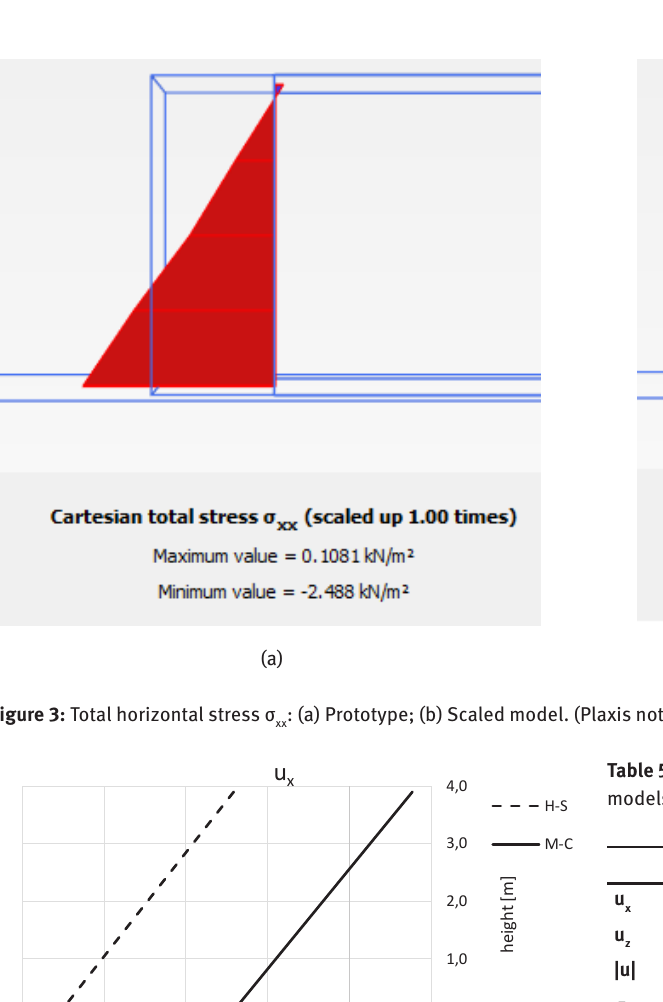
Figure 4: Effect on the predicted prototype behavior of two constitutive models (Mohr-Coulomb and Hardening Soil): results are shown in terms of displacements along x -direction ( u